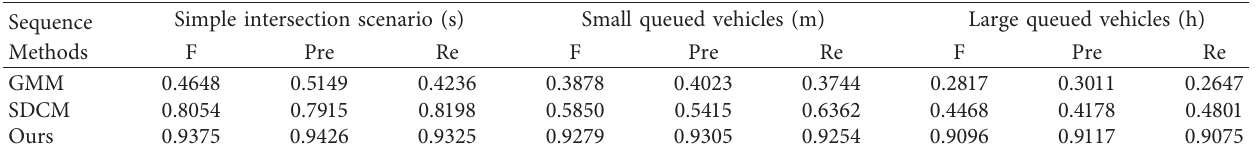
Figure 9: Detection results in complex intersection scenarios (many queued Table 3: Comparison of the metrics for test sequences.